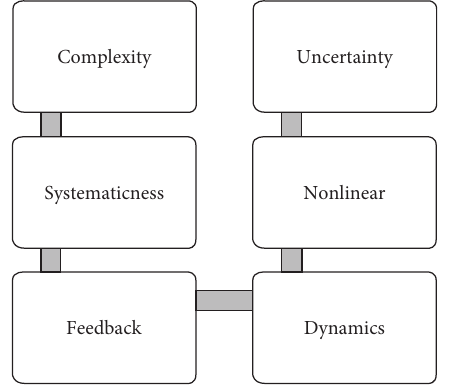
Figure 2: Typical characteristics of economic system.